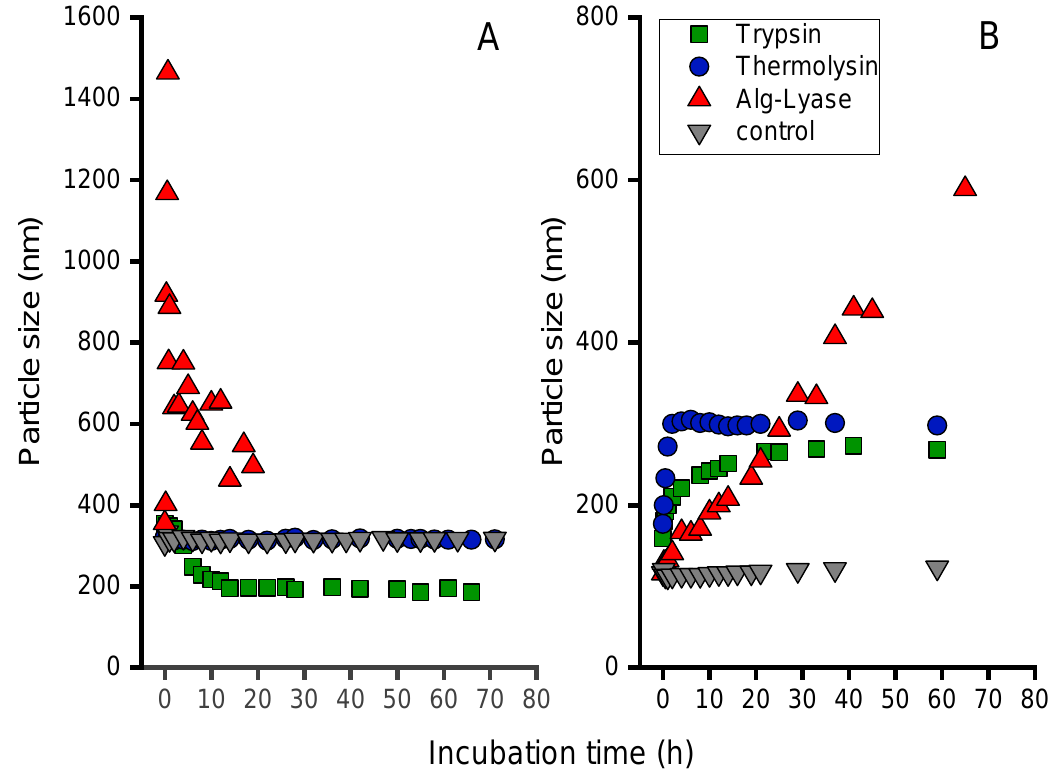
Figure 3. Degradation studies for ( A ) Alg/PLL and ( B ) Alg/NITEGE nanoparticles in MilliQ water (filled triangles) at 37 °C. After formation, the particles were coincubated with enzyme solutions (each 2.5 µg/mL) of thermolysin, trypsin, and alginate-lyase for up to 80 h. The particle size was monitored over the incubation time through DLS.